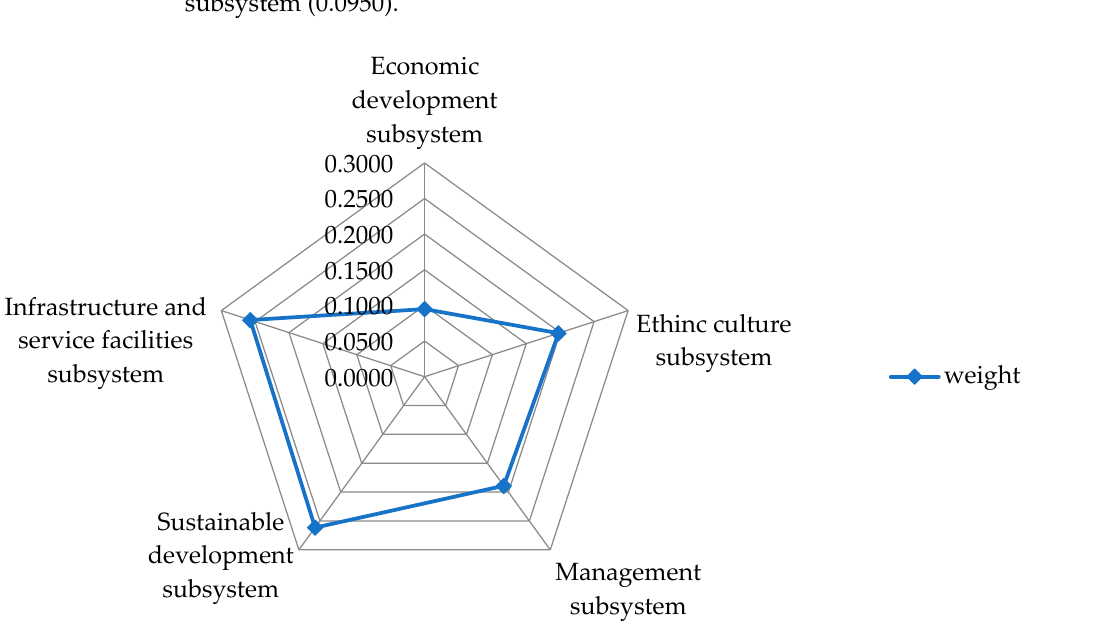
Figure 1. Criterion layer weight radar chart.